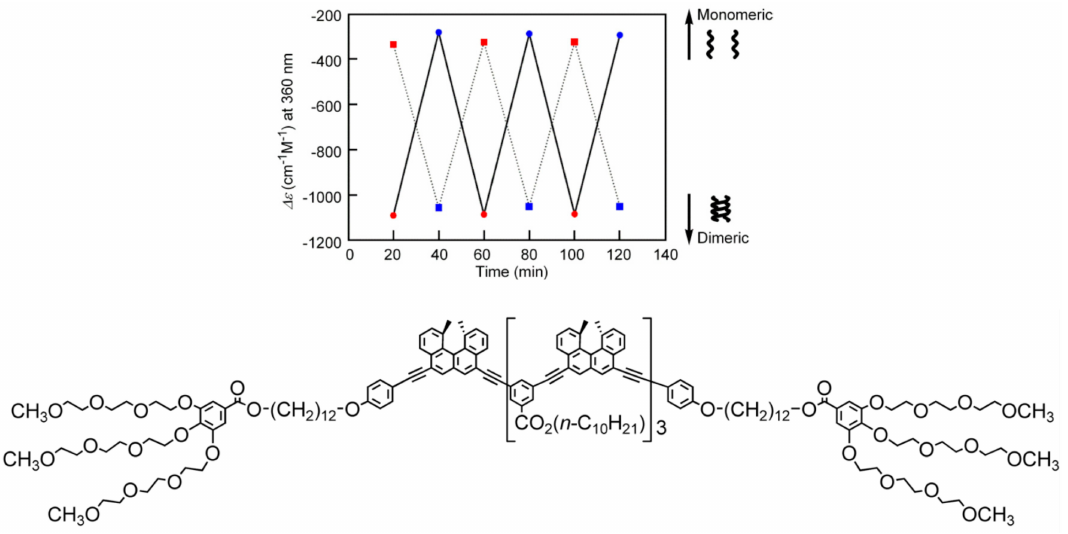
Figure 15. Ordinary thermo response (dotted lines) and inverse thermo response (solid lines) shown by ∆ ε (360 nm)/time profiles at temperature switching between 5 and 60 ◦ C shown in blue and red circles, respectively. Chemical structure of a PEG ( P )-tetramer is also shown.